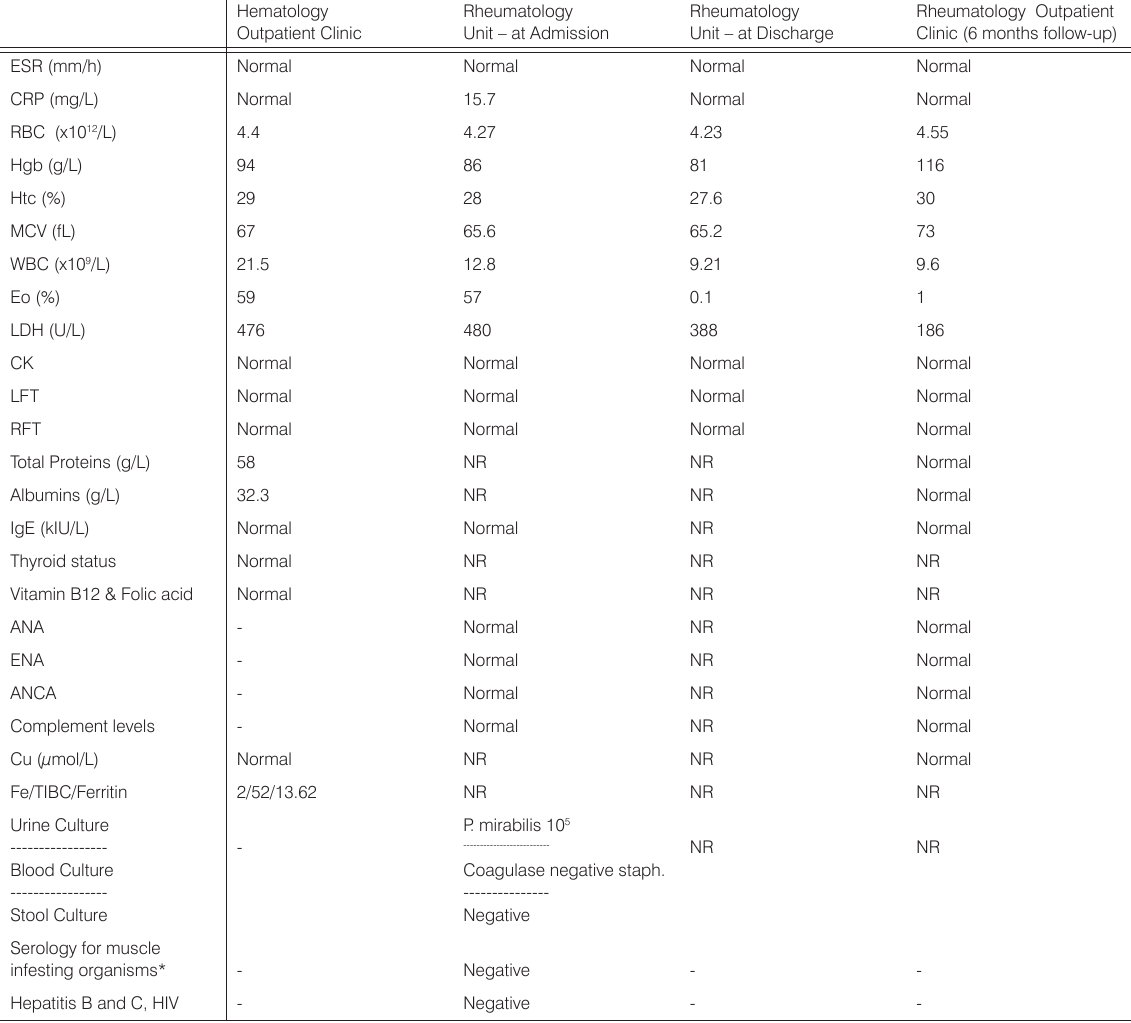
Table 2. Laboratory